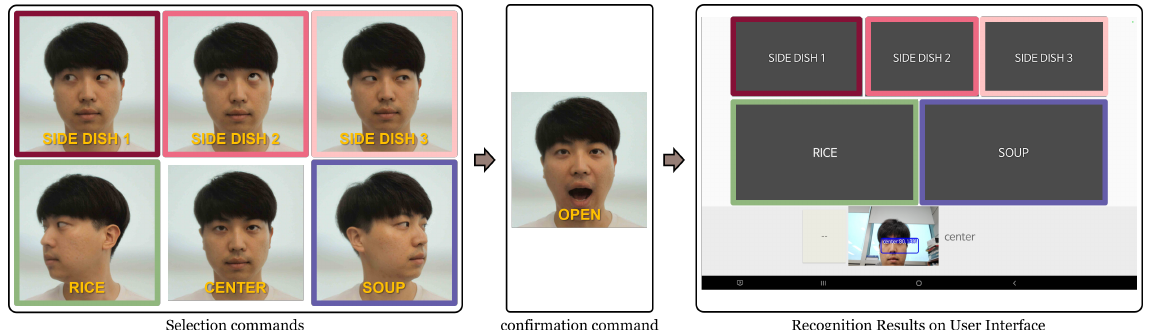
Figure 11. Mapping between facial recognition results and food selection. The color-boxed user facial movements on the left are mapped to the same color-boxed food in the tablet interface on the right. The user can select the food they wants by using their facial movements as input commands. Once the desired food is selected, the user can send an acquisition command to the robot using the “open” command. In the case of ’center’ without a colored box, this is not mapped with a specific dish and is used as a neutral command to reduce the misselection of side dishes.